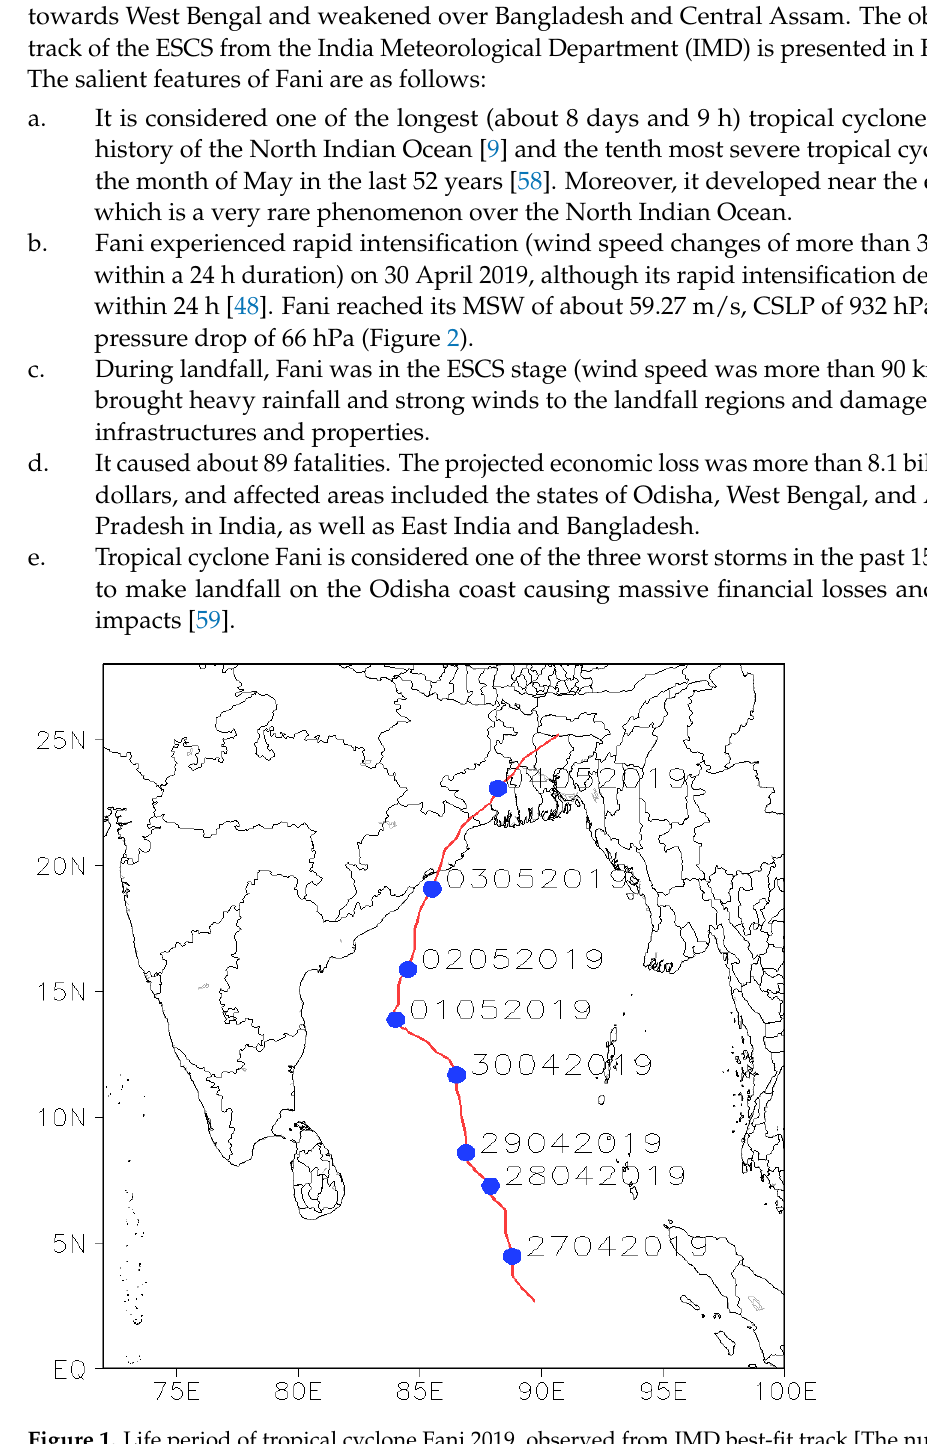
Figure 1. Life period of tropical cyclone Fani 2019, observed from IMD best-fit track [The numeric in the figure indicates the date information in the format of DDMMYYYY].